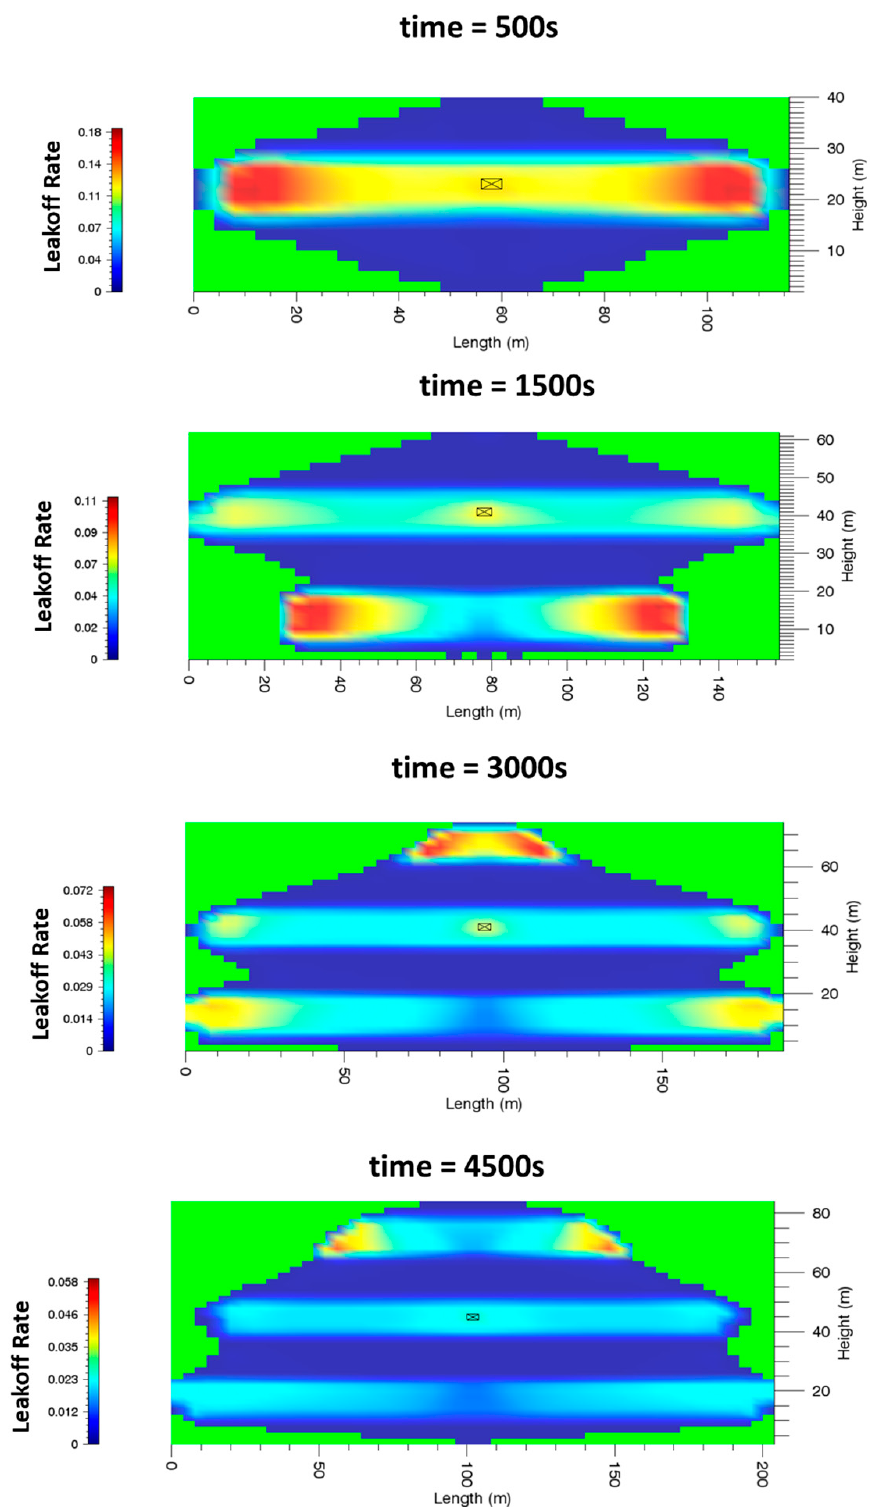
Figure 11. Variation of leakoff rate distribution of Case 1 during the injection.